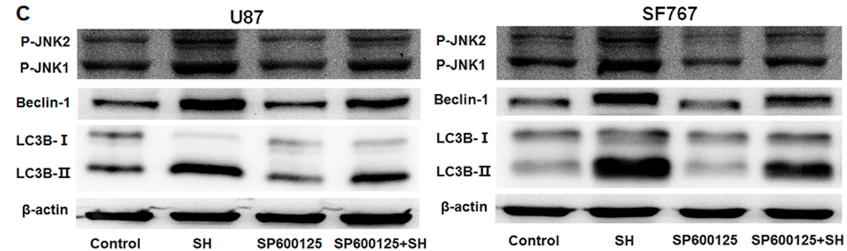
Figure 4. Inhibition of the Akt-mTOR pathway and activation of the JNK pathway are implicated in SH-mediated autophagy. ( A ) SH dose-dependently suppressed the Akt-mTOR pathway and activated the JNK pathway in U87 and SF767 cells, along with the induction of autophagy. The cells were treated with different concentrations of SH for 24 h; ( B ) Effects of IGF-1 on SH-mediated autophagy and suppression of the Akt-mTOR pathway in U87 and SF767 cells. The cells were treated with SH (0.5 mM) for 24 h in the absence or presence of IGF-1; ( C ) Effects of SP600125 on SH-mediated autophagy and the JNK pathway activation in U87 and SF767 cells. The cells were treated with SH (0.5 mM) for 24 h in the absence or presence of SP600125. β -actin served as the loading control. All blots shown are representative of n = 3 experiments, with similar results.